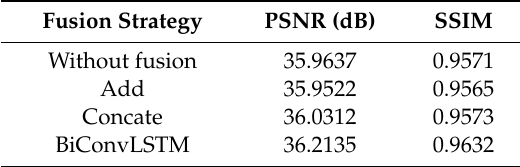
Table 2. Comparison of the average results on the COWC testing sets in terms of PSNR and SSIM for the scale factor × 2 by using di ff erent strategies to fuse the hierarchical features. Selectively extracting information from low-level features further improved the model